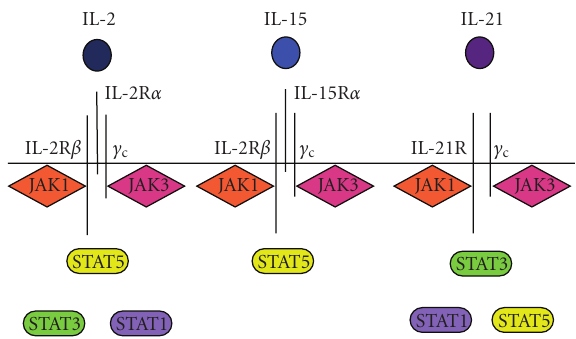
Figure 2: IL-2 superfamily. IL-2, IL-15, and IL-21 are closely related in receptor binding, and function. IL-2 and IL-15 bind trimeric receptors and two of the three chains (IL-2R β , γ c ) are the same, while each cytokine binds a unique third component of the receptor (IL-2 α or IL-15 α , respectively). The dimeric IL-21R consists of the γ c chain, shared with IL-2R and IL-15R, and a unique chain, IL- 21R. All three cytokines utilize the Janus kinases signaling molecules JAK1 and JAK3. IL-2 and IL-21 can activate STAT1/3/5 while IL-15 is only known to activate STAT5. While IL-2 and IL-21 can activate multiple STAT family members, IL-2 primarily signals through STAT5 homodimers whereas IL-21 mostly signals through STAT3